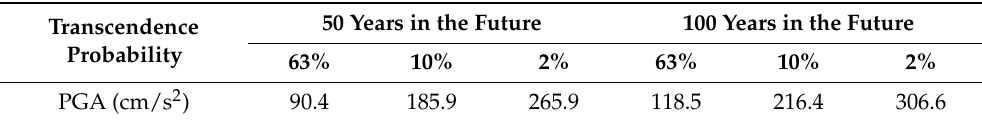
Table 6. Peak value of the horizontal bedrock ground motion acceleration under different probabilities of